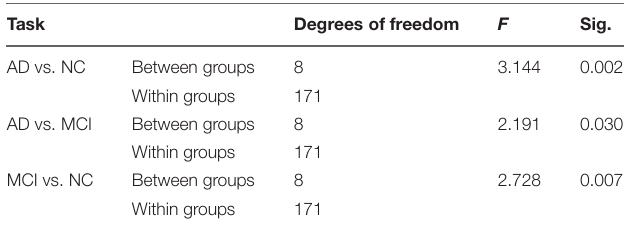
TABLE 6A | Statistical analysis results for classification performances from nine tractography algorithms using PCA. (A) One-way ANOVA. Task Degrees of freedom F Sig.